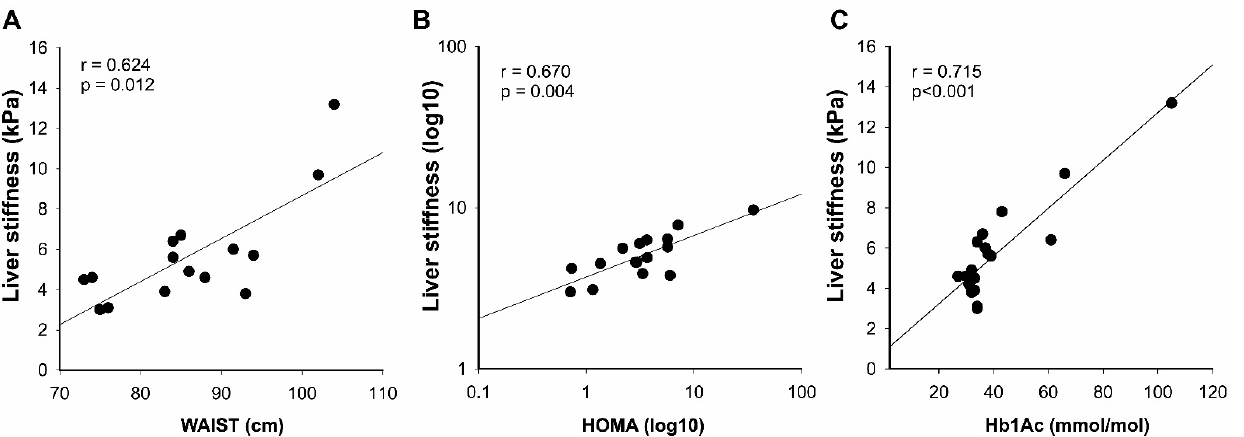
Figure 5. Correlation analysis of the liver stiffness and biomarkers of metabolic complications in patients with ALMS. The simple correlations between liver stiffness evaluated by the shear wave elastography and waist (n = 15) ( A ), and homeostasis model assessment (HOMA; n = 15) ( B ), and glycated hemoglobin 1Ac (Hb1Ac) (n = 14) ( C ) were performed by Spearman’s correlation in the indicated patients with ALMS. Data were transformed into logarithmic values in ( B ).